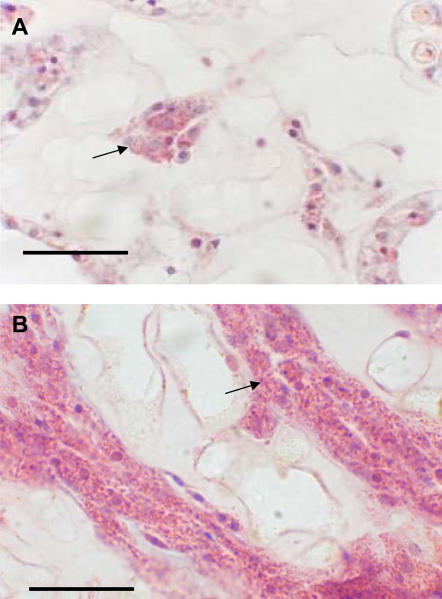
Amoebocytes in mesoglea (connective tissue) of naturally diseased sea fan corals.A) Healthy coral with granular amoebocytes dispersed in mesoglea as indicated by arrows. B) Diseased coral with an increase in granular amoebocytes in the mesoglea. Scale bar = 25 µm.